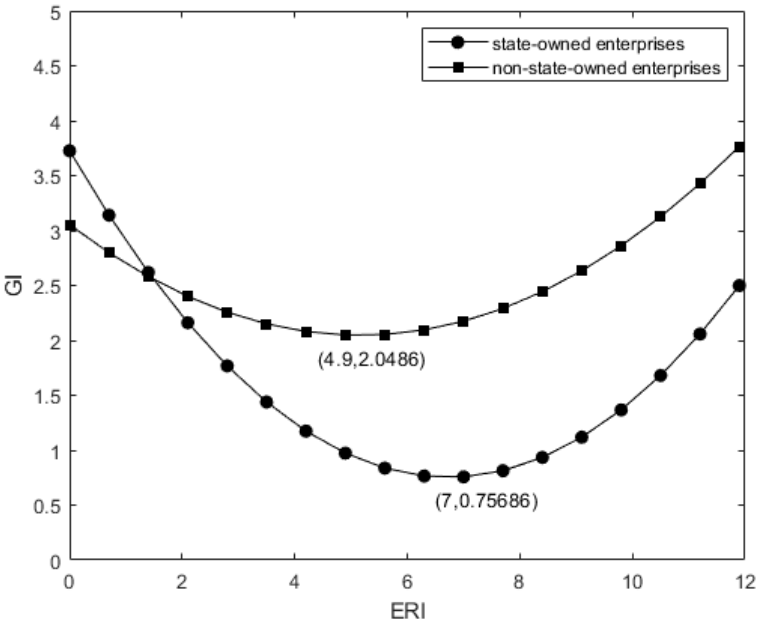
Figure 4. Comparison of the U-shaped relationship between environmental regulation and green innovation in state-owned and non-state-owned enterprises.